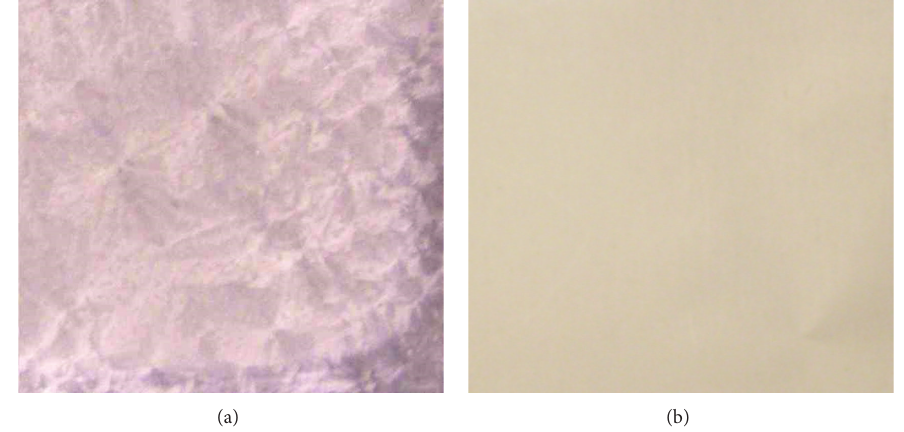
Figure 1: The appearance of drug-loaded patch prepared from arecoline hydrobromide (a) and arecoline base